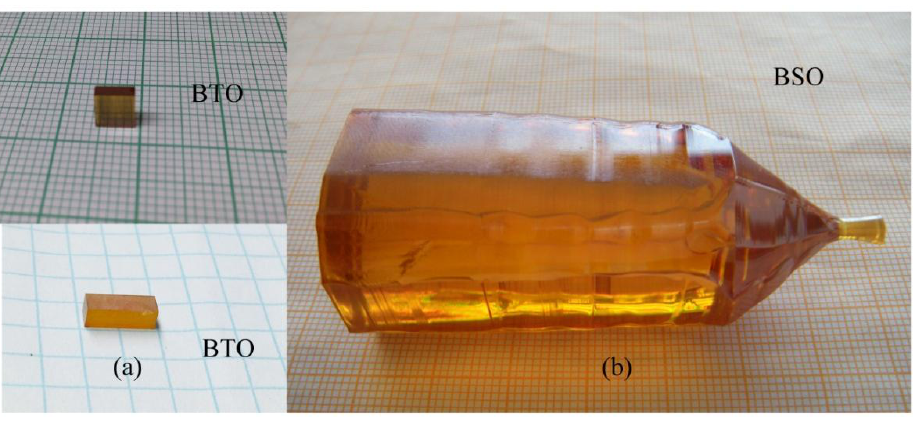
TiO (BTO) samples; ( b ) The as-grown Bi 12 20